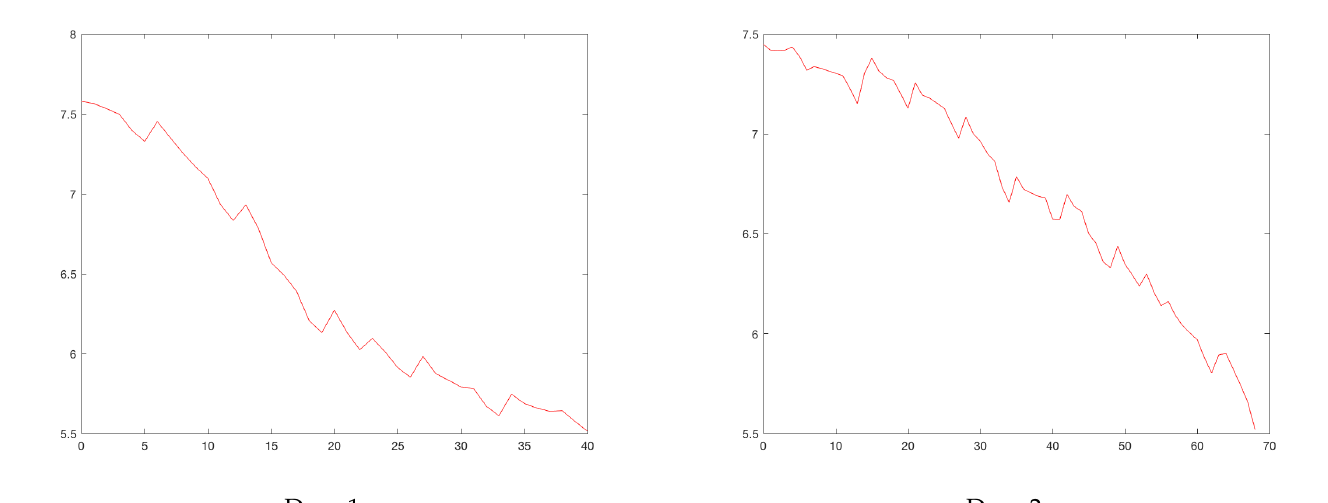
Figure A25. Paris’s drops. Horizontal axis, days; vertical axis: logarithm of daily